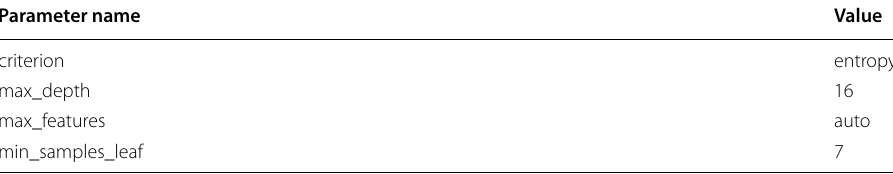
Parameter values for classifier yielding best results in terms of AUPRC Table 106 Modes of XGBoost tuned hyperparameter values for experiments with the keylogging dataset